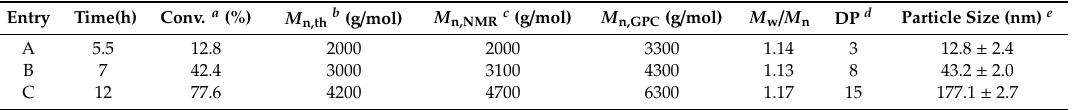
Table 1. Polymerization of BnMA via photo-BIT-RDRP.